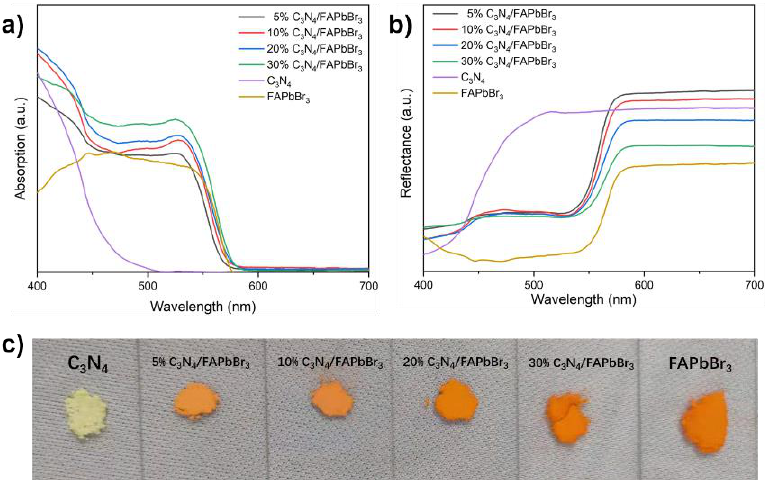
Figure 2. ( a ) UV-vis absorption spectrum of FAPbBr 3 /C 3 N 4 hybrids materials with different weight ratio of FAPbBr 3 ; ( b ) UV-vis diffuse reflectance spectrum and ( c ) digital photographs of FAPbBr 3 /C 3 N 4 hybrids.